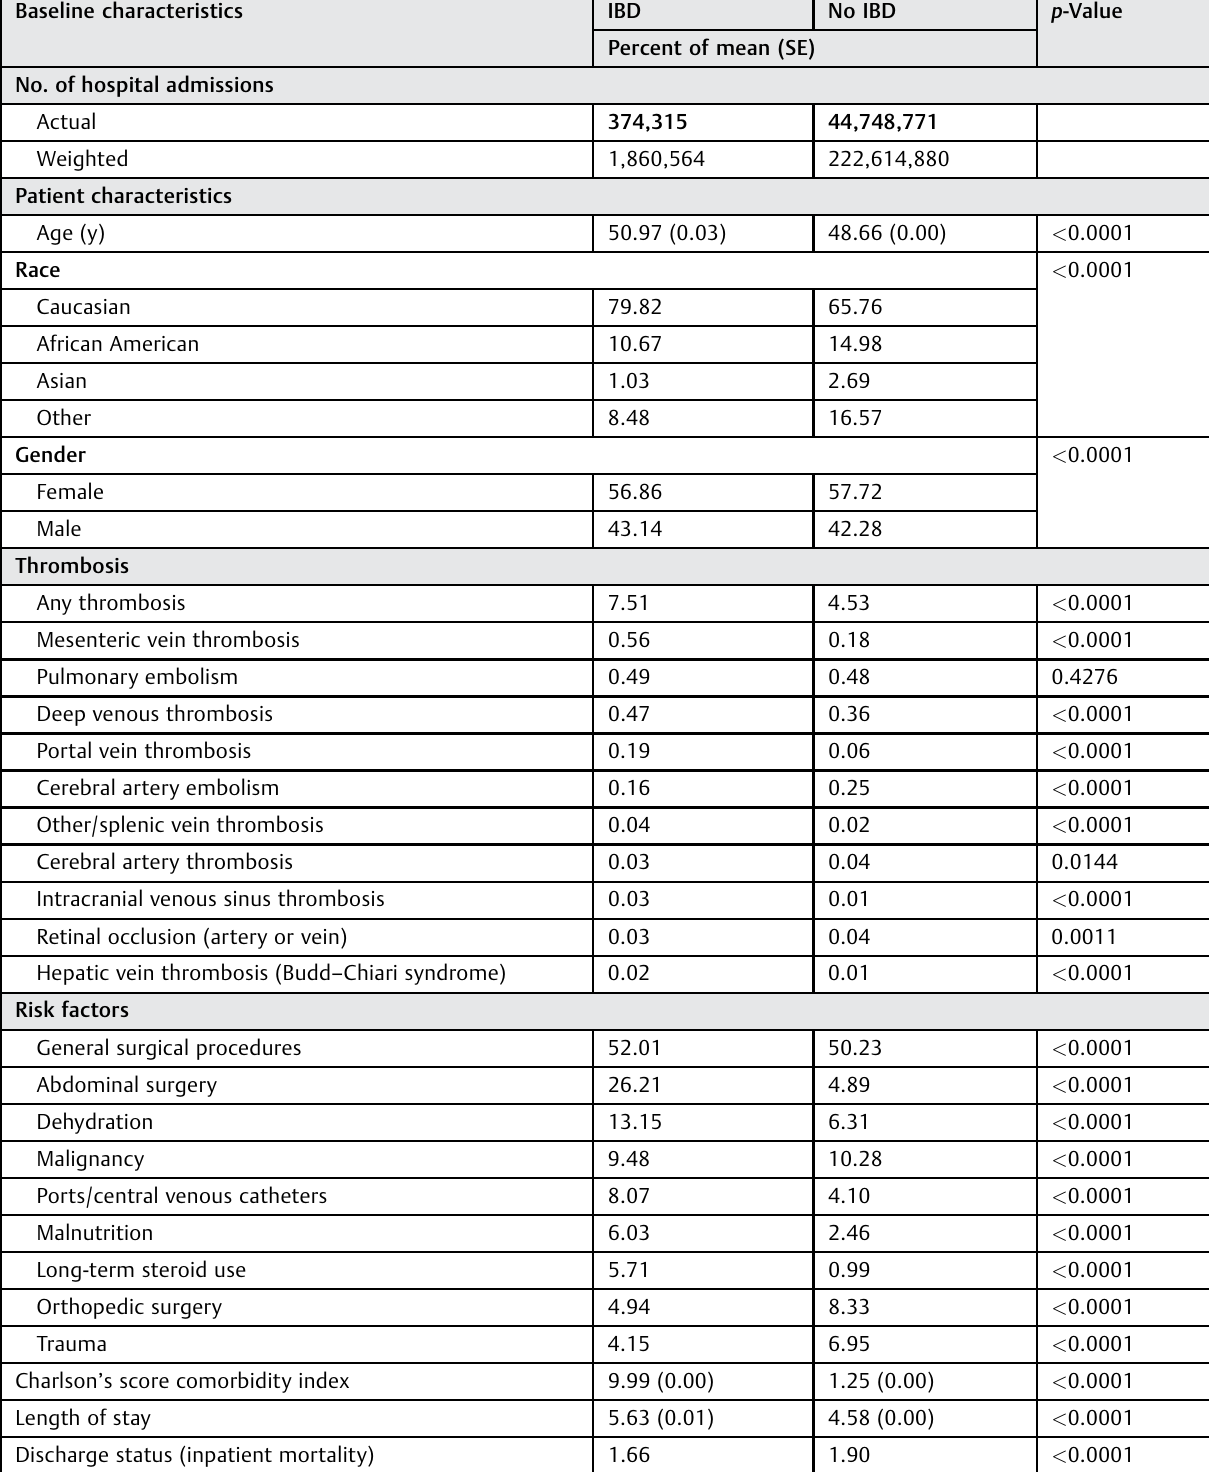
Table 1 Characteristics of IBD and non-IBD admissions from 2009 to 2014 Baseline